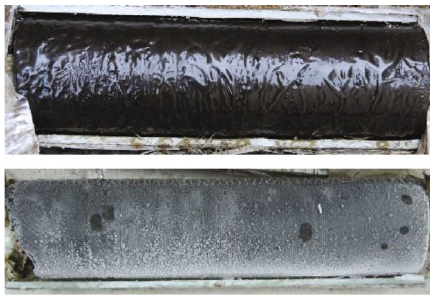
Figure 1: Oil sand core at room temperature and in a frozen state.